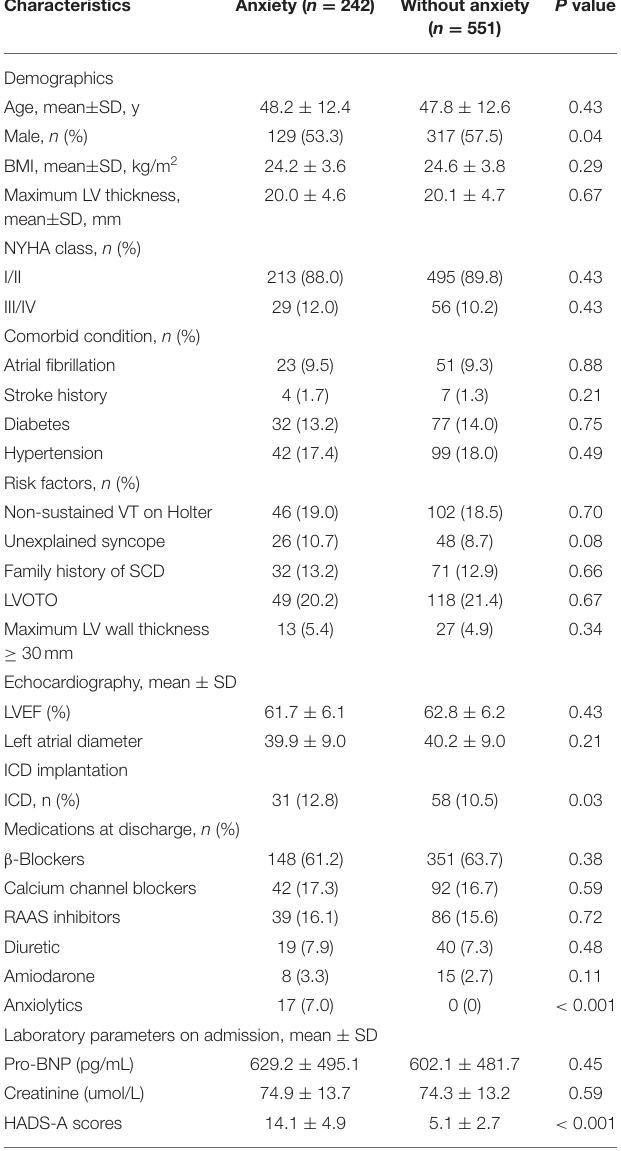
TABLE 1 | Demographic and baseline characteristics of the study population with or without anxiety. Characteristics